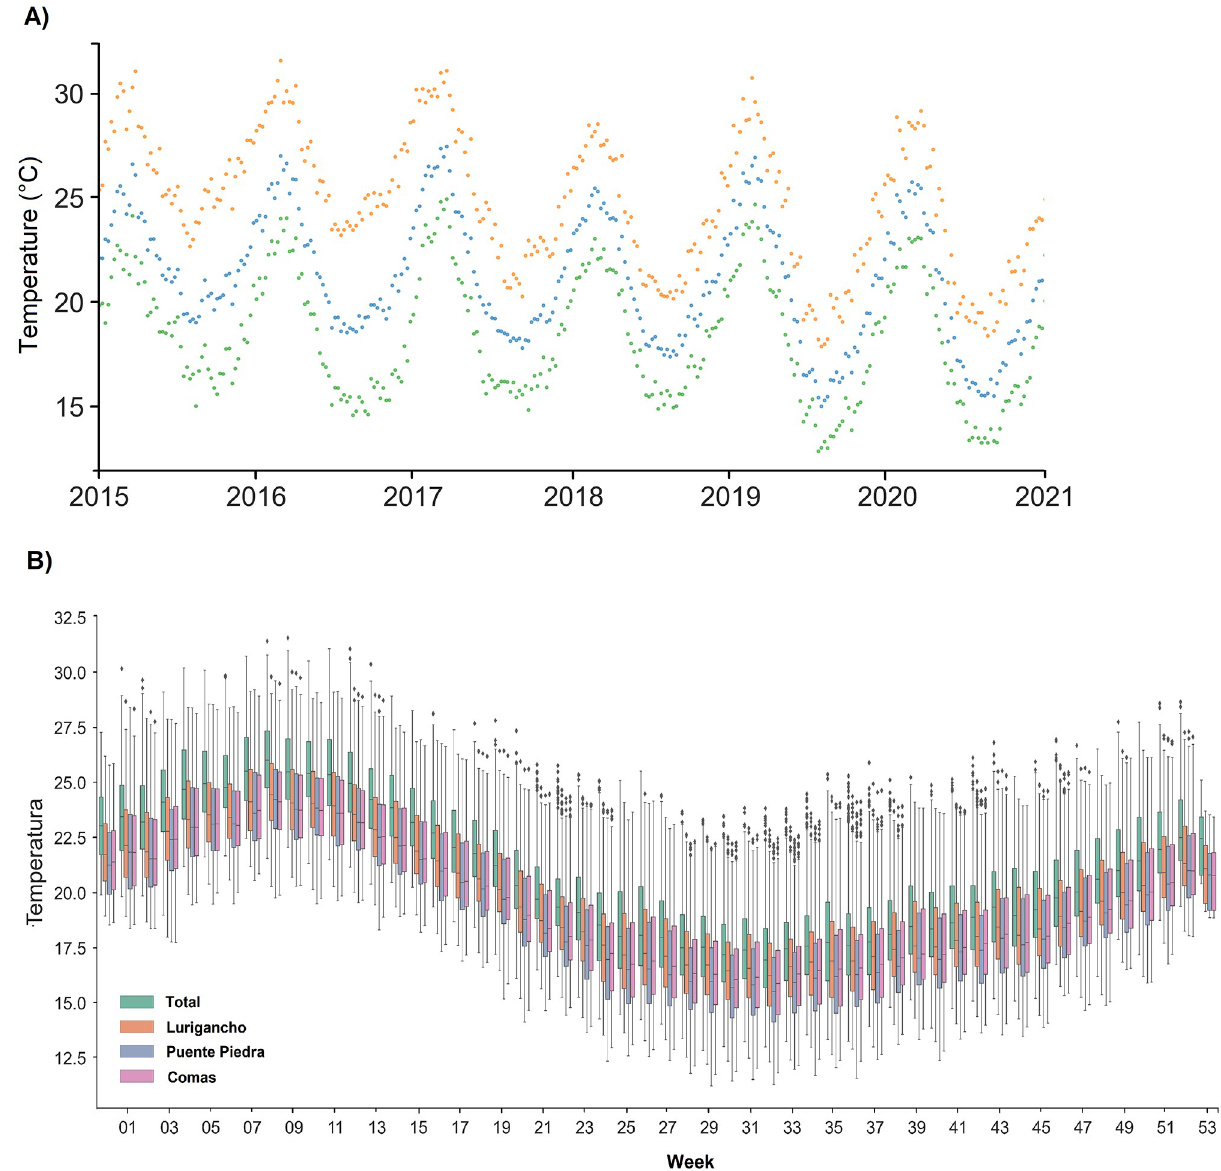
Fig 2. Temperature distribution between 2015 and 2020 in Lima, Peru: (A) Weekly minimum (green), maximum (orange), and average (blue) temperatures between 2015 and 2020. (B) Box plots showing the temperature distribution for each epidemiological week and for each district.